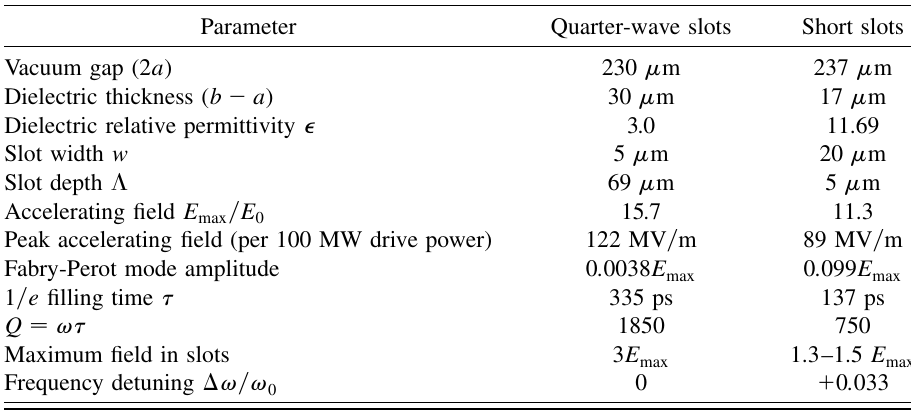
TABLE I. Structure dimensions and filling parameters from time-dependent 2D simulation for the two versions of the 340 - (cid:2) m slab-symmetric structure presented in Figs. 5 and 6. Parameter Quarter-wave